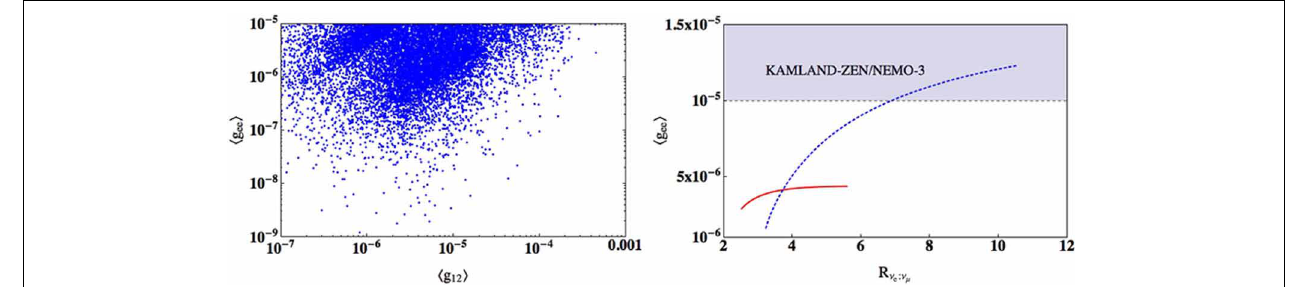
and the parameter (cid:9) g ee (cid:10) Right panel: correlation between R ν e : ν μ for two particular points of the left panel, varying in this case the value of δ